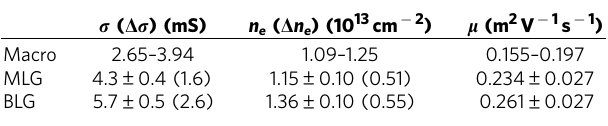
Table 2 | Results for defect resistance r Defect for the different types of defects in SiC–graphene and the change in magnetic field.